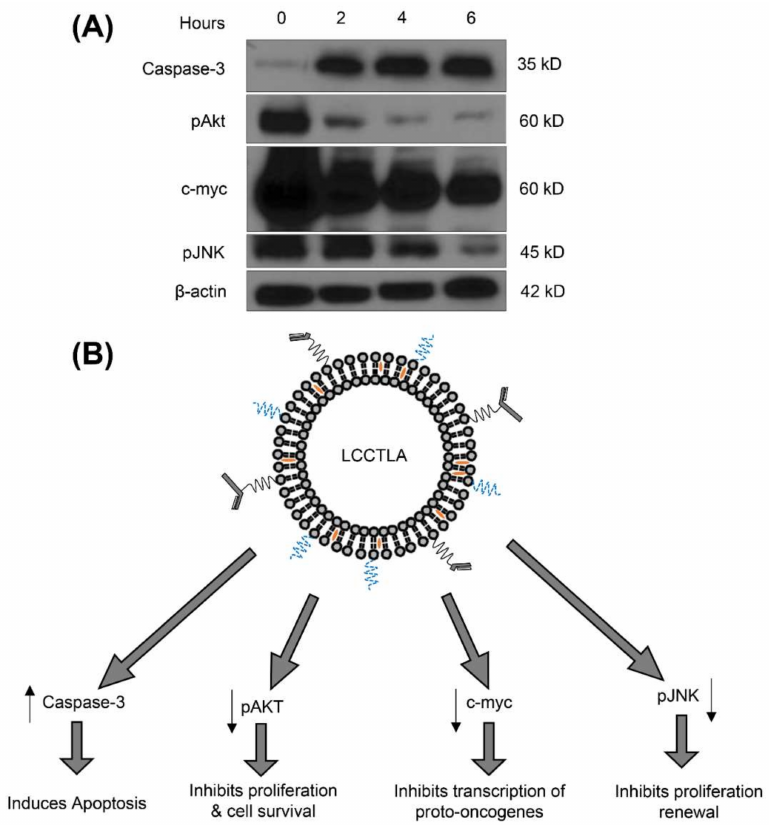
Figure 8. ( A ) Western blot results for the expression patterns post LCCTLA treatment for 3 time points, 2, 4 and 6 h; and ( B ) Effect of LCCTLA on the expression of caspase-3, pAKT, c-myc and